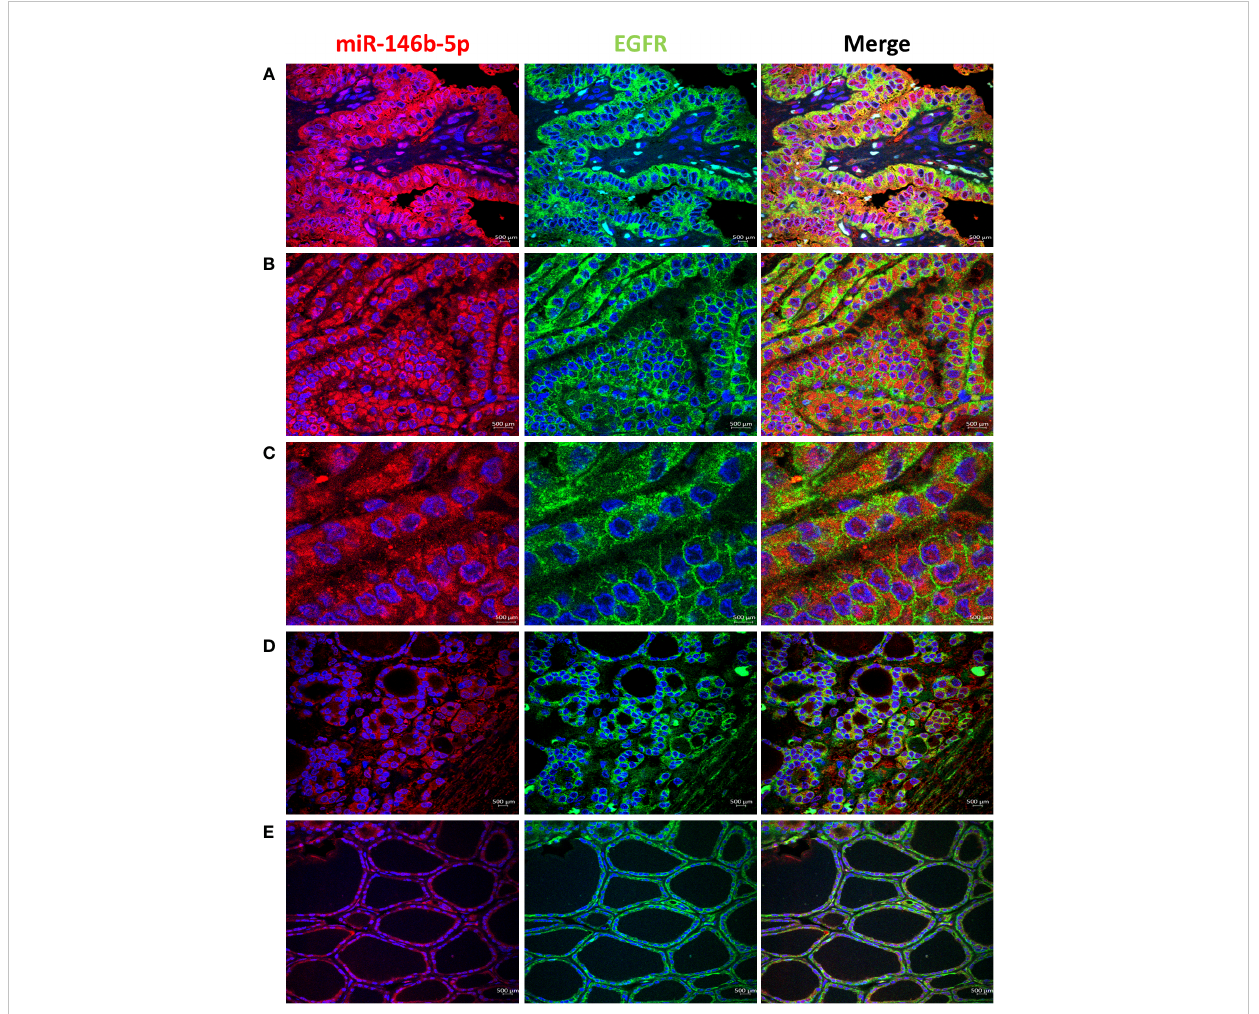
FIGURE 1 Expression of EGFR (green) and miR146b-5p (red) in representative samples. (A) PTC showing strong EGFR expression that colocalizes with miR-146 in the cytoplasm of tumor cells. (B) EGFR expression is enriched in the cell membrane in parts of the tissues in PTC. (C) In PTC cytoplasmic and membranous EGFR expression coexist in the same fi eld and is not related to difference in miR-146b-5p level of expression. (D) NIFTP sample showing low cytoplasmic/membranous EGFR expression along with low miR-146b-5p expression in tumor cells. (E) FND sample showing low membranous EGFR expression and low miR-146b-5p in the follicular